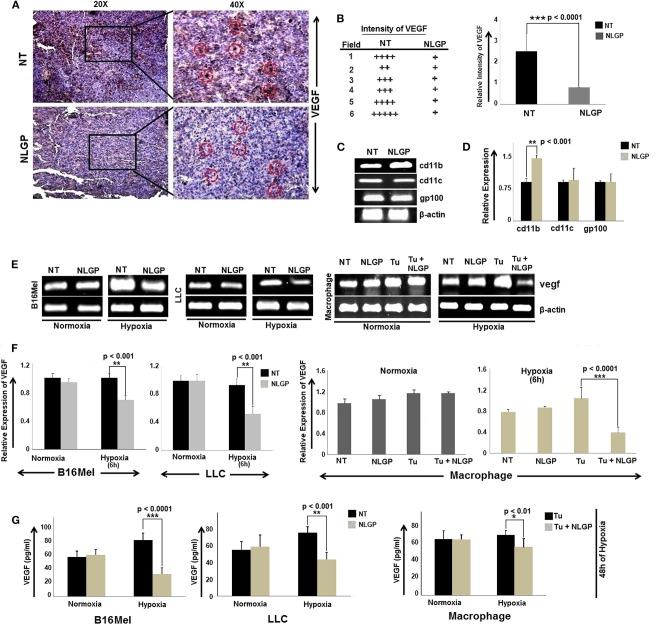
NLGP downregulates VEGF expression in tumor, cultured cancer cells and immune cells. (A) Immunohistochemical expression of VEGF in untreated and NLGP treated murine B16Mel tumor tissue. (B) Representative figures from tumor bearing (n = 6) hosts are presented in 20X and 40X magnification. Intensity of staining in six different fields from tumor sections of untreated and NLGP treated mice. Mean ± SD of staining intensity of VEGF are also shown. (C) Tumors from untreated and NLGP treated (1.5 μg/ml) C57BL6/J mice were cryosectioned and mRNA expression of cd11c, cd11b, gp100 genes after laser capture microdissection of VEGF positive zones were measured using RT-PCR, keeping β-actin as loading control. (D) A bar diagram represents the mean ± SD of relative expression of respective genes (n = 4). (E) Expression of vegf gene is shown in B16Mel, LLC and macrophages cultured in both normoxic and hypoxic conditions (6 h of NLGP and hypoxia exposure) (n = 6 for each cell type), keeping β-actin as loading control. (F) Bar diagrammatic representation show mean ± SD of relative expression of vegf from all untreated and NLGP treated cell lines. (G) A bar diagram showing mean ± SD (n = 6) of VEGF levels as measured by ELISA in B16Mel, LLC and macrophage cells obtained from both hypoxic and normoxic conditions, w/wo NLGP. Cells were pre-treated for 48 h in NLGP and kept in 12 h hypoxia. P-values showing significance of difference are indicated in respective bar diagrams.